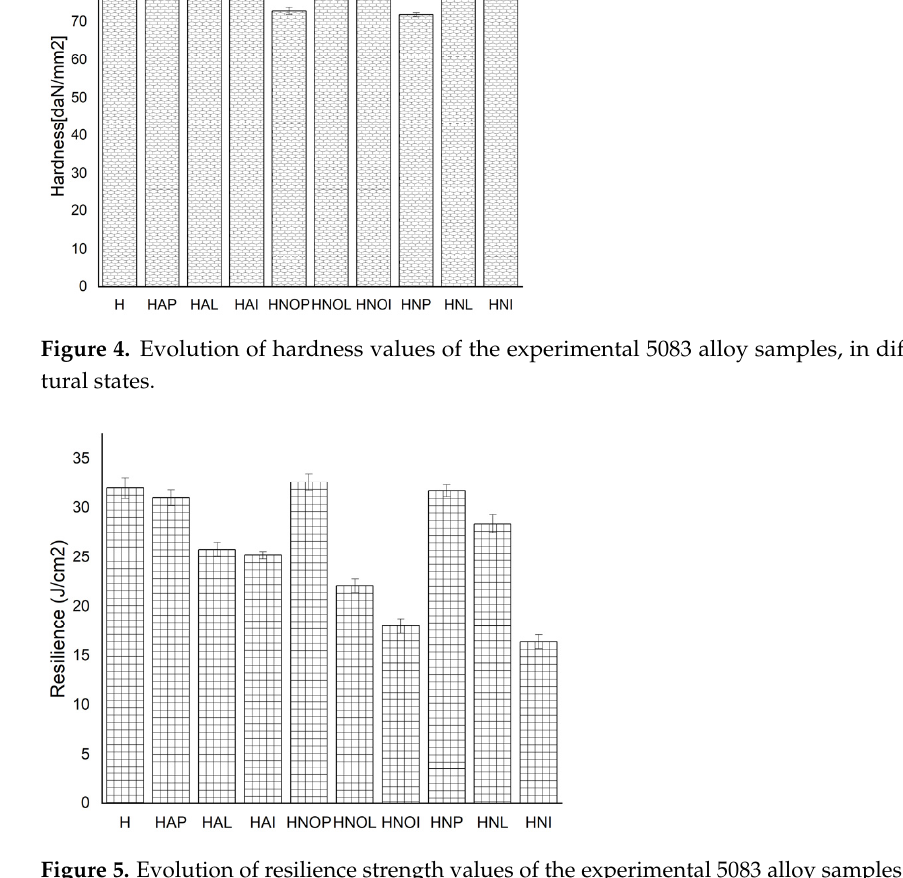
Figure 5. Evolution of resilience strength values of the experimental 5083 alloy samples, in different structural states.